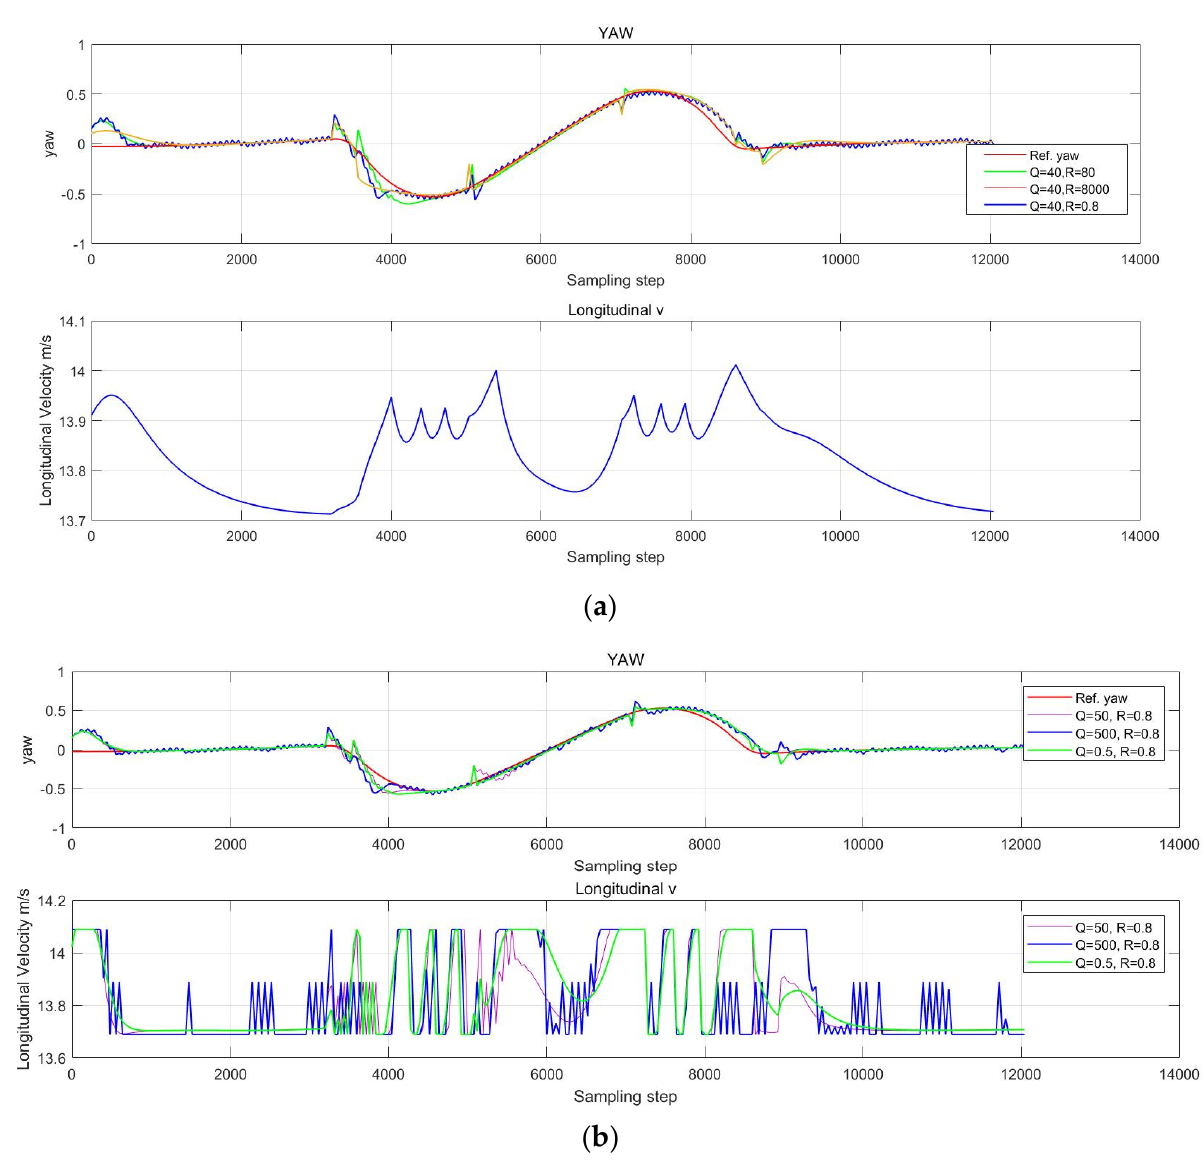
Figure 6. ( a ) Shows the comparison of yaw rate after changing the weighting parameter R; Q = 40, R = 0.8 still achieves the best performance. ( b ) Shows the comparison of yaw rate after changing the weighting parameter Q; Q = 50, R = 0.8 still achieves the best performance.